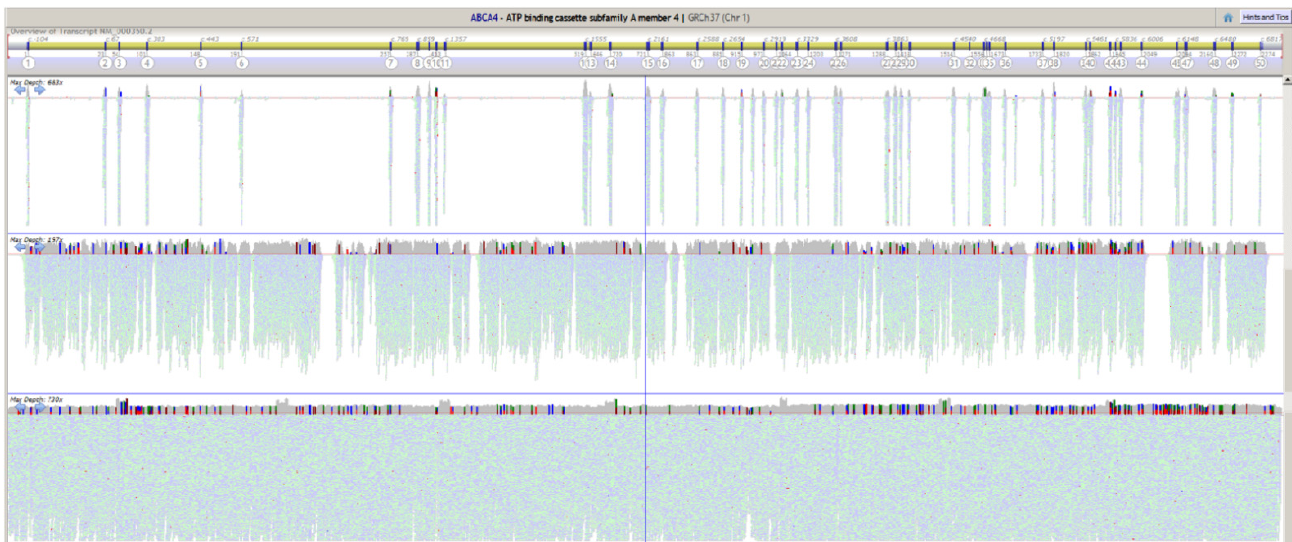
Figure 1. ABCA4 coverage comparison of different assays. Screenshot of the Alamut Visual software showing the coverage results for the ABCA4 locus from different next-generation sequencing assays. On the top, the software illustrates the relative exon locations. Below the gene structure, coverage plots for a typical whole-exome sequencing assay (top), custom capture probes assay (middle), and, finally, the long-range polymerase chain reaction method (bottom).